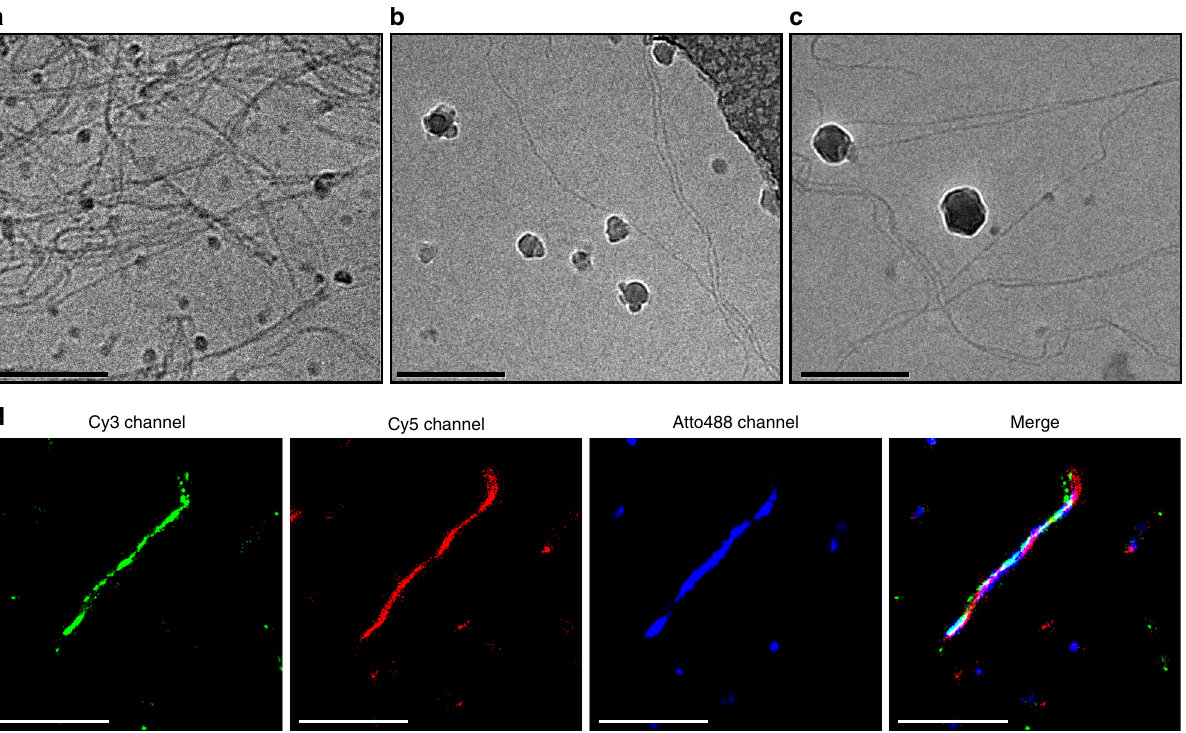
Fig. 2 Structural characterization of DNA-decorated BTA polymers and recruitment of proteins. Cryo-TEM images of DNA-decorated BTA polymers in PBS (50 mM sodium phosphate, 500 mM NaCl, pH 7.0) with a 150 μ M BTA-3OH and 50 μ M BTA-DNA (25% BTA-DNA), b 195 μ M BTA-3OH and 5 μ M BTA- DNA (2.5% BTA-DNA), 2 μ M R E and R I , and c 195 μ M BTA-3OH and 5 μ M BTA-DNA (2.5% BTA-DNA), 2 μ M R E and R I , 10 nM β -lactamase and 100 nM BLIP. The scale bars represent 200 nm. The dark spherical objects present in the images are crystalline ice particles. d Stochastic optical reconstruction microscopy imaging of BTA polymers in TE/Mg 2+ (10 mM Tris-HCl, 1 mM EDTA, 12.5 mM MgCl 2 , pH 8.0) with 1.4 μ M BTA-3OH, 0.5 μ M BTA-DNA and BLIP. The individual dyes were imaged sequentially and reconstructed in separate channels. The scale bars represent 2 µ